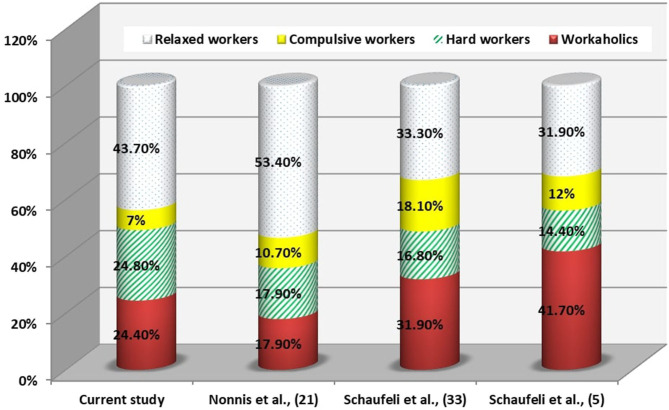
Comparison of the profiles of the current study with other research in health care.